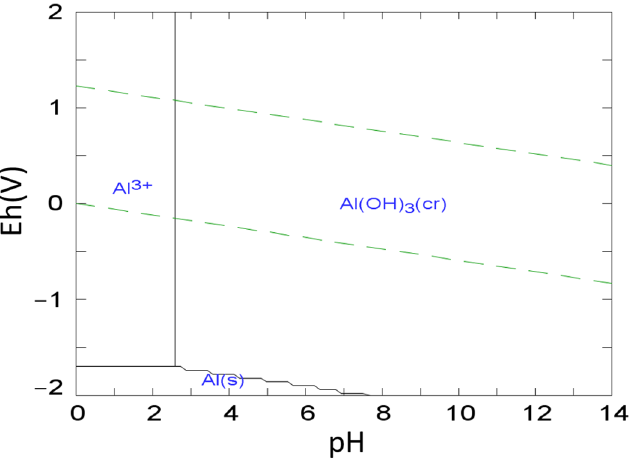
Figure 6. Pourbaix Diagram of the Al–H 2 O system at 25 °C. Simulation in the software Hydra-